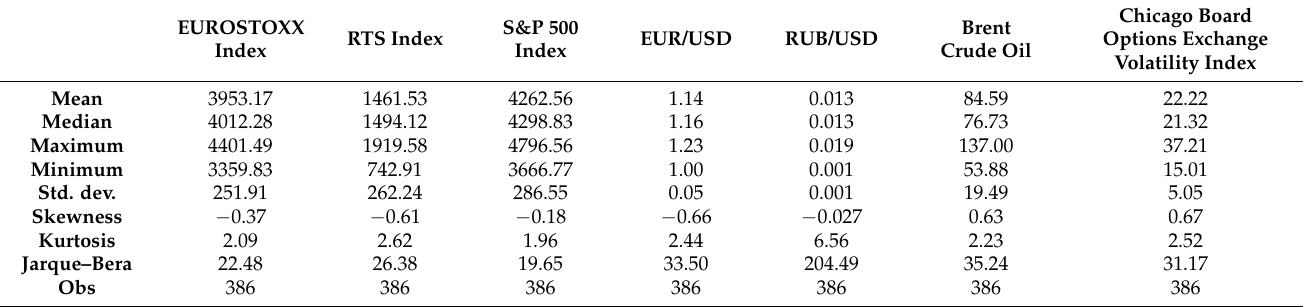
Table 1. Descriptive